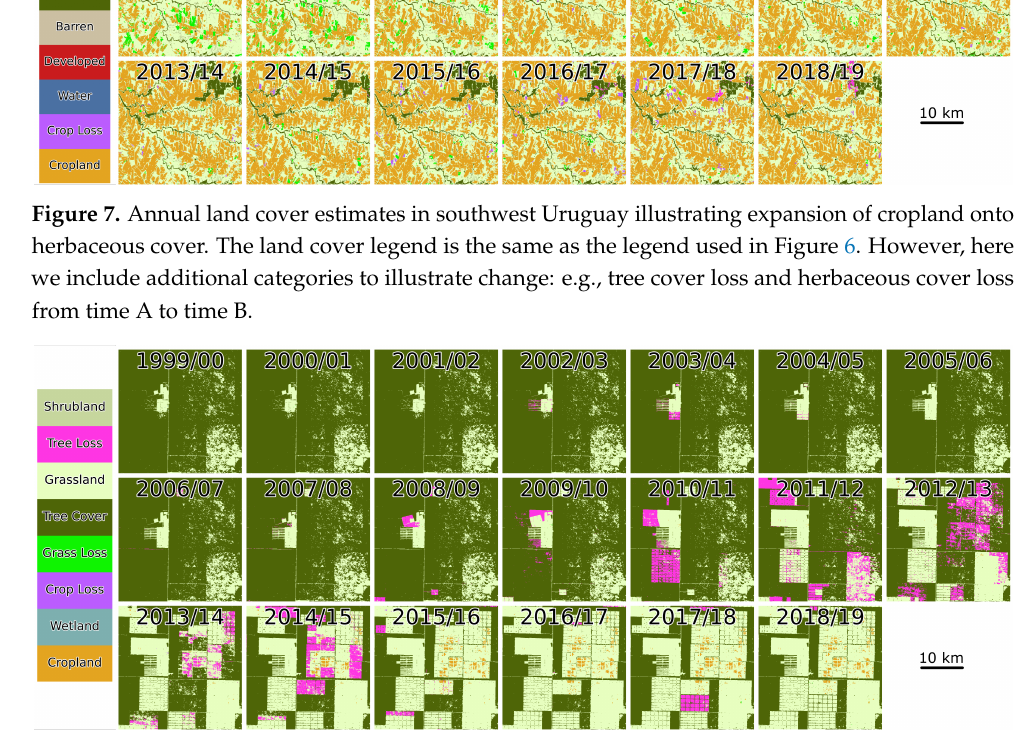
Figure 8. Annual land cover estimates in the Paraguayan Chaco illustrating expansion of herbaceous cover at the expense of tree cover loss. The land cover legend is the same as the legend used in Figure 6. However, here we include additional categories to illustrate change: e.g., tree cover loss and herbaceous cover loss from time A to time B.